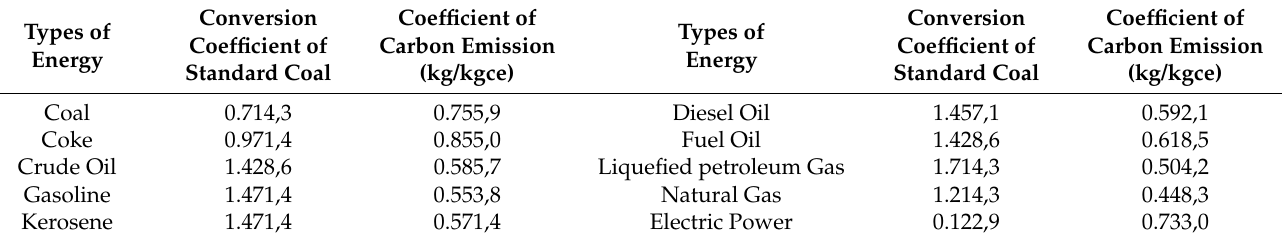
Table 2. Carbon emission coefficients of